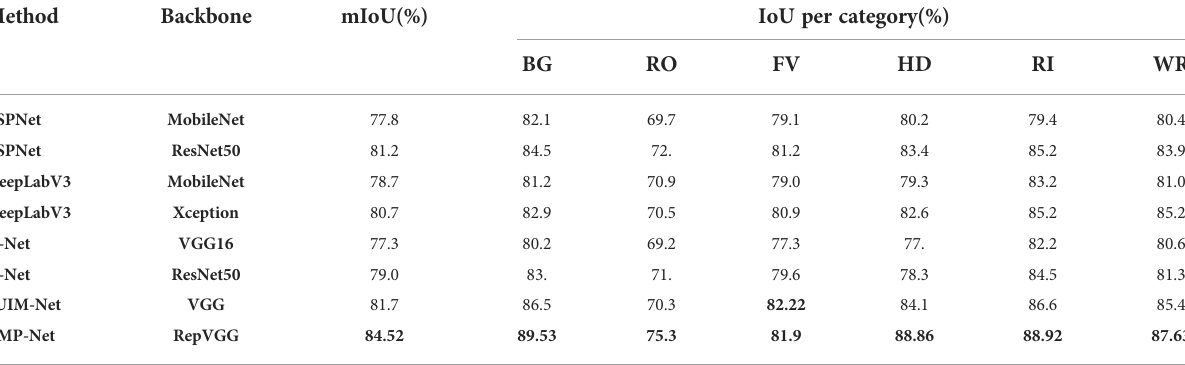
TABLE 5 Comparing mIoU metrics between different models on the SUIM dataset, where the metrics with the highest rankings are shown in bold.